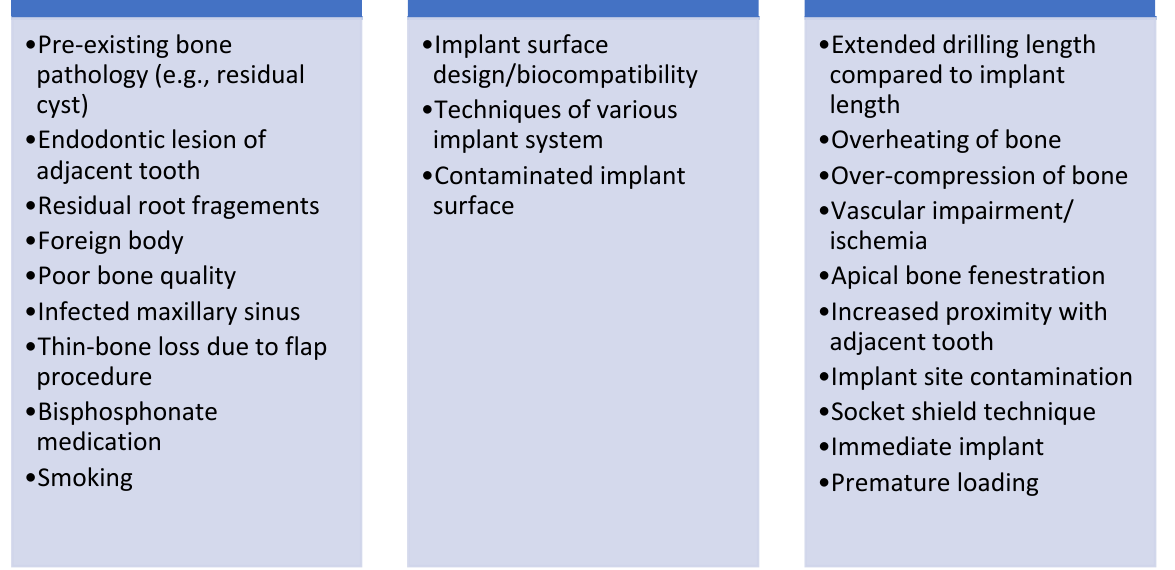
Figure 1. Possible etiologies of implant periapical lesion (IPL): subject-associated factors, material-associated factors, and method-associated